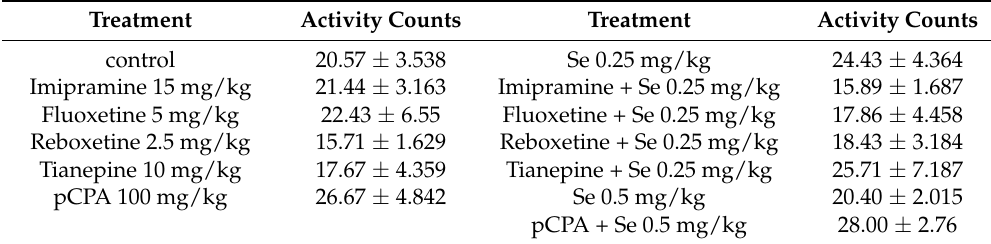
Table 1. Effect of the administration of sodium selenite Se (0.25 and 0.5 mg/kg), antidepressants, and p-chlorophenylalanine (pCPA) on locomotor activity in mice. The values represent the mean of the motility of mice between 2nd and 6th min ± SEM (standard error of the mean).